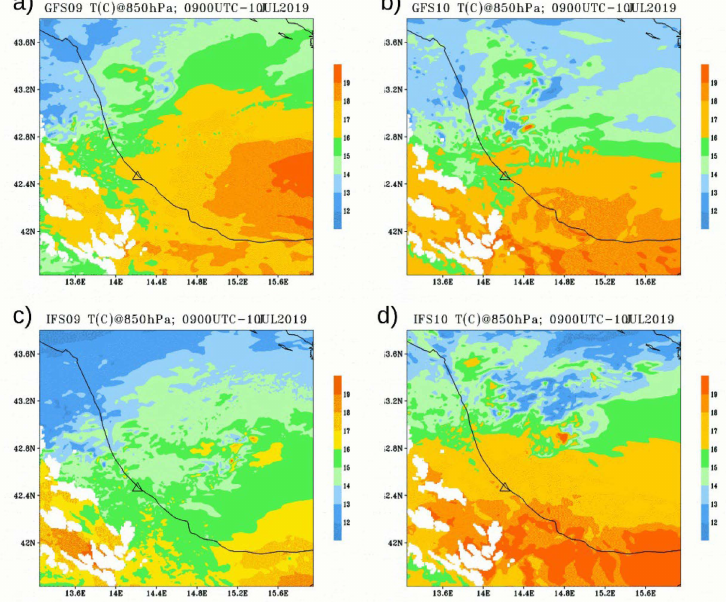
Figure 7. Temperature at 850 hPa at 09:00 UTC, 10 July 2019, according to: GFS09 ( a ), GFS10 ( b ), IFS09 ( c ), and IFS10 ( d